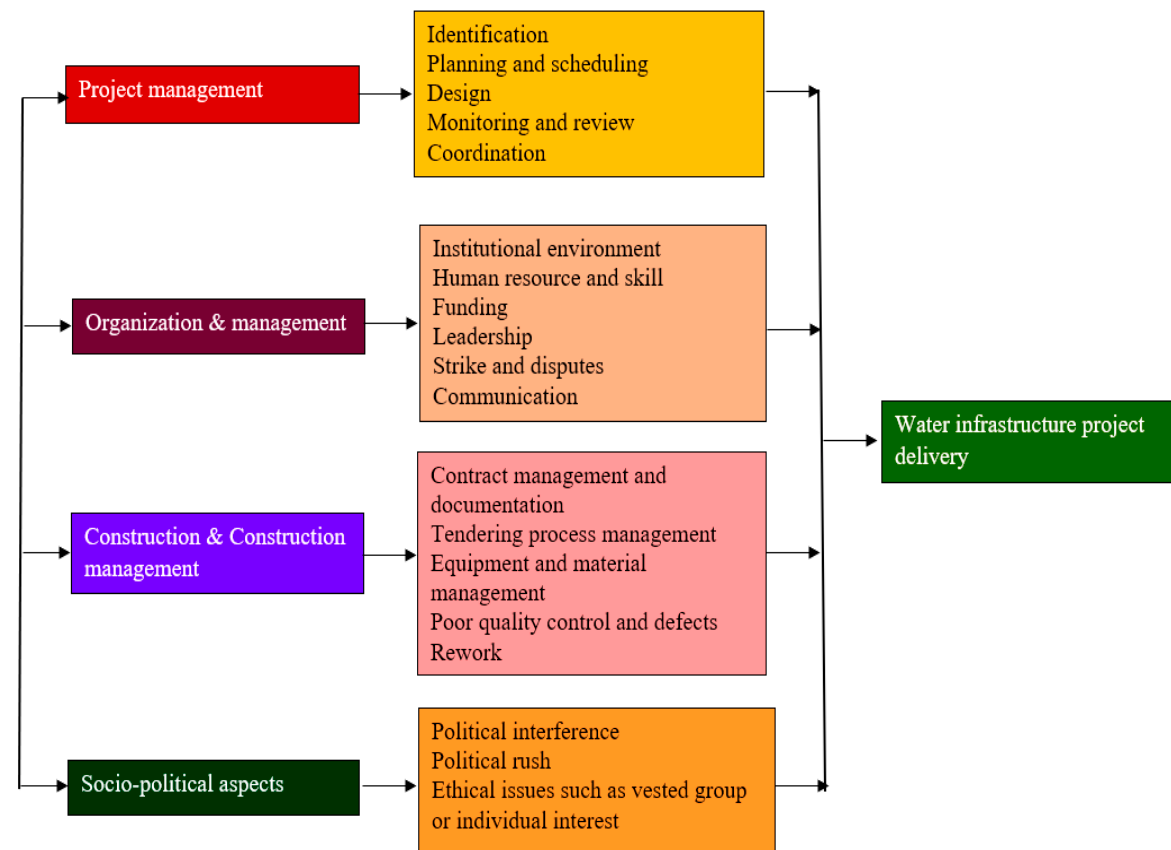
Figure 2. Conceptual framework of different aspects and factors influencing water infrastructure project delivery.